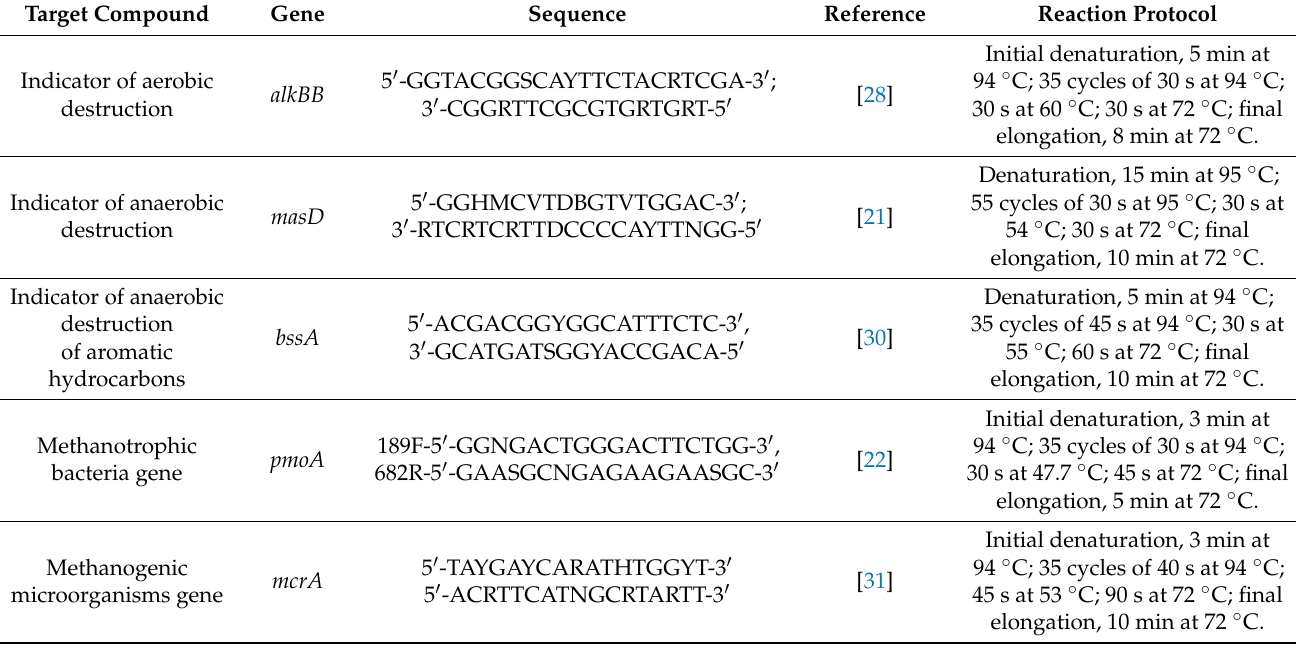
Table 2. Oligonucleotide sequences of primers used in this